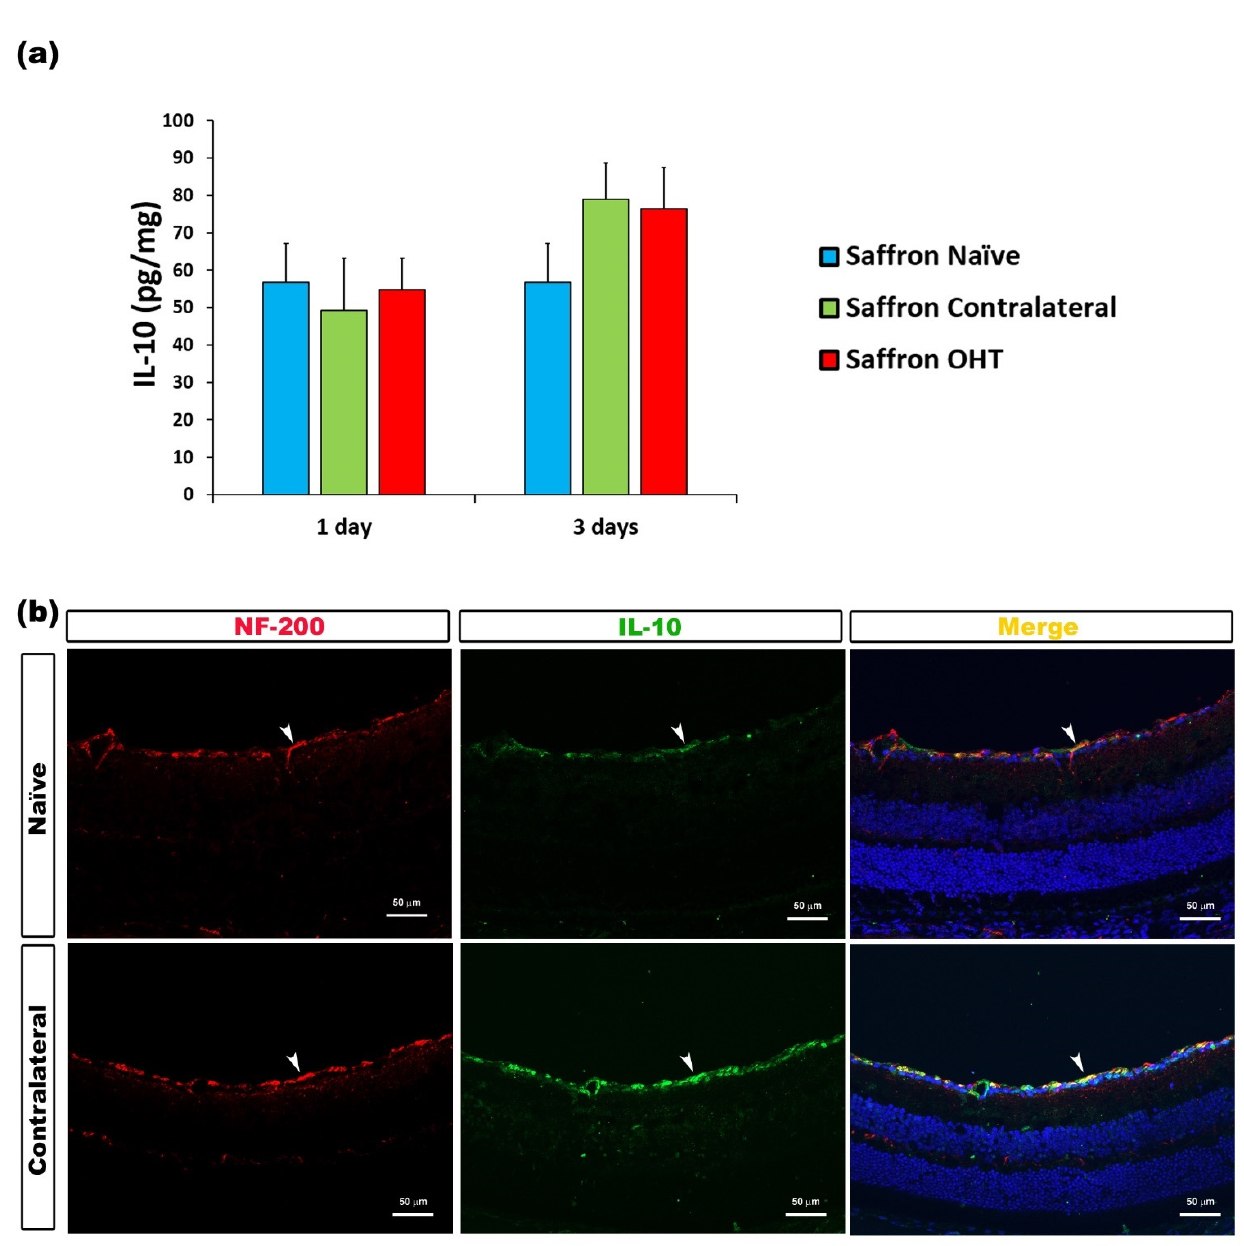
Figure 8. IL-10 levels at 1 and 3 days after laser-induced ocular hypertension (OHT). ( a ) The IL-10 values obtained in the multiplex assay. The histogram shows the mean levels ( ± SD) of IL-10 (pg/mg) at days 1 and 3 after laser OHT induction in saffron ocular hypertension eyes (saffron OHT) and saffron-contralateral eyes (saffron-contralateral) as well as in naïve eyes. ( b ) Immunohistochemical study of IL-10 expression in saffron-contralateral eyes three days after unilateral laser-induced OHT. Retinal sections were immunolabeled with antibodies to IL-10 (green) and NF-200 (red). Merge is denoted by the colour yellow. The arrowhead shows the co-expression of Iba-1 and IL-10 in saffron-contralateral and saffron-naïve eyes. Abbreviations: OHT (ocular hypertension); IL-10 (interleukin-10); NF-200 (neurofilament-200 KDa).